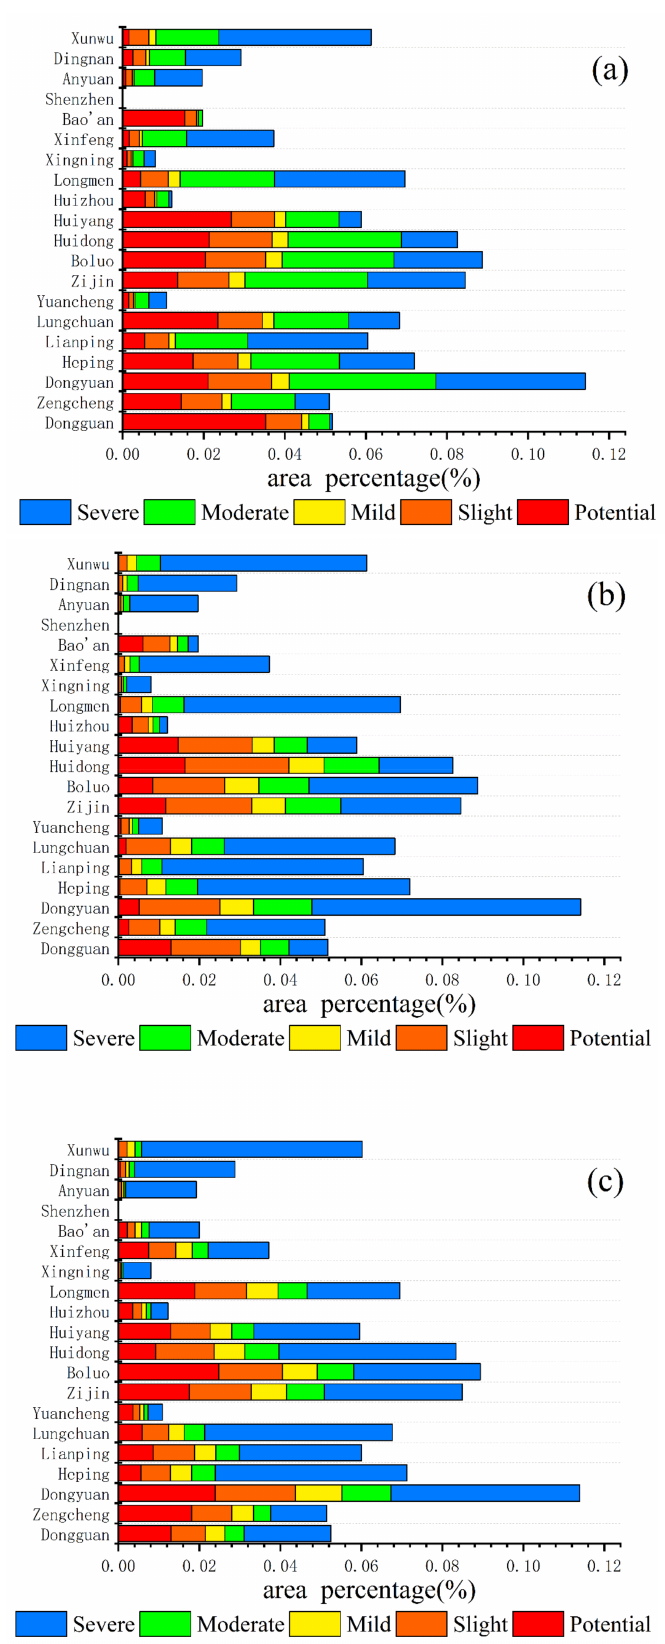
Figure 4. Scale map of vulnerability areas at different levels ( a ) 2001; ( b ) 2008; ( c )